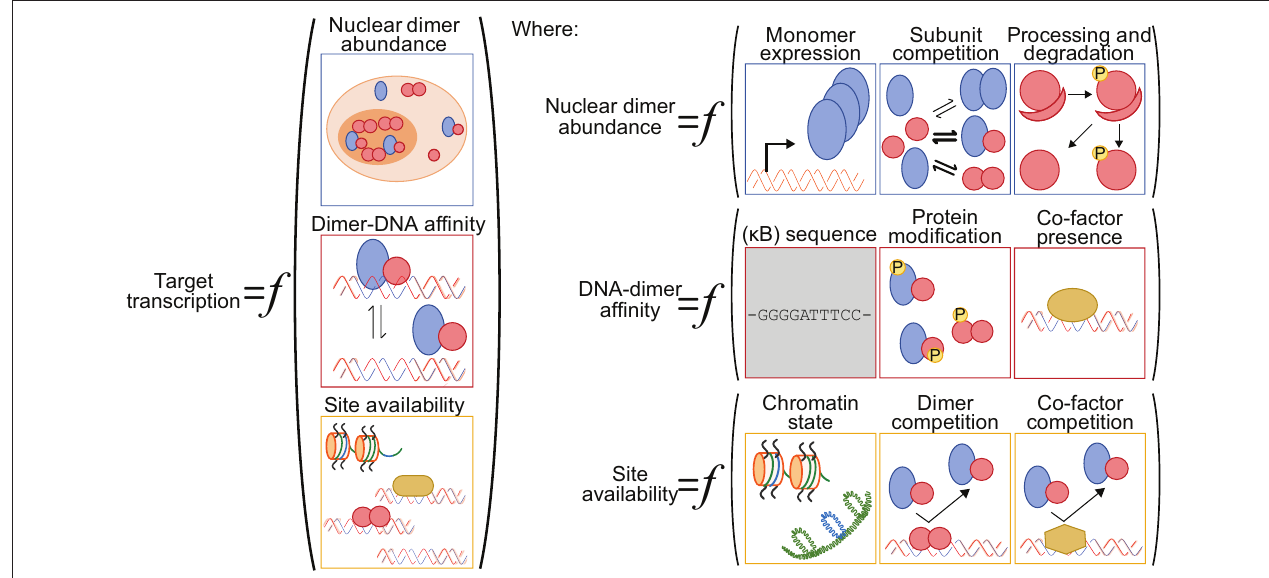
FIGURE 2 | A generalized function for NF- κ B-driven gene regulation. Schematic diagram of quantitative and qualitative factors that can differentially modulate NF- κ B-driven gene regulation gene-by-gene and across various cellular contexts. Broadly speaking, target gene transcription is set by the nuclear abundance of NF- κ B dimers, the NF- κ B-DNA binding affinity and the availability of the DNA binding sites (left). The nuclear abundance of NF- κ B dimers is itself a function of NF- κ B subunit monomer expression, of NF- κ B subunit competition in the various dimerization reactions, and of processing and degradation of inhibitory domains (ankyrin-rich domains of p105 and p100) and inhibitory proteins (I κ Bs) (top right panel). The NF- κ B-DNA binding affinity is influenced by the DNA sequence (for both consensus κ B sites and non-consensus sites), by NF- κ B dimer identity and their post-translation modifications, and by the presence of regulatory co-factors that may help recruit NF- κ B dimers to DNA or stabilize the interactions (center right panel). We note here that the DNA sequence is, arguably, the only factor that is not cell-type specific (gray shading). Finally, the availability of DNA binding sites for interaction with an NF- κ B dimer is a function of the chromatin state, including the presence of histones and histone modifications, of competition from other NF- κ B dimers and their relative affinities for the same site, and of competition with other regulatory factors that may bind to and occlude the potential binding site (bottom right